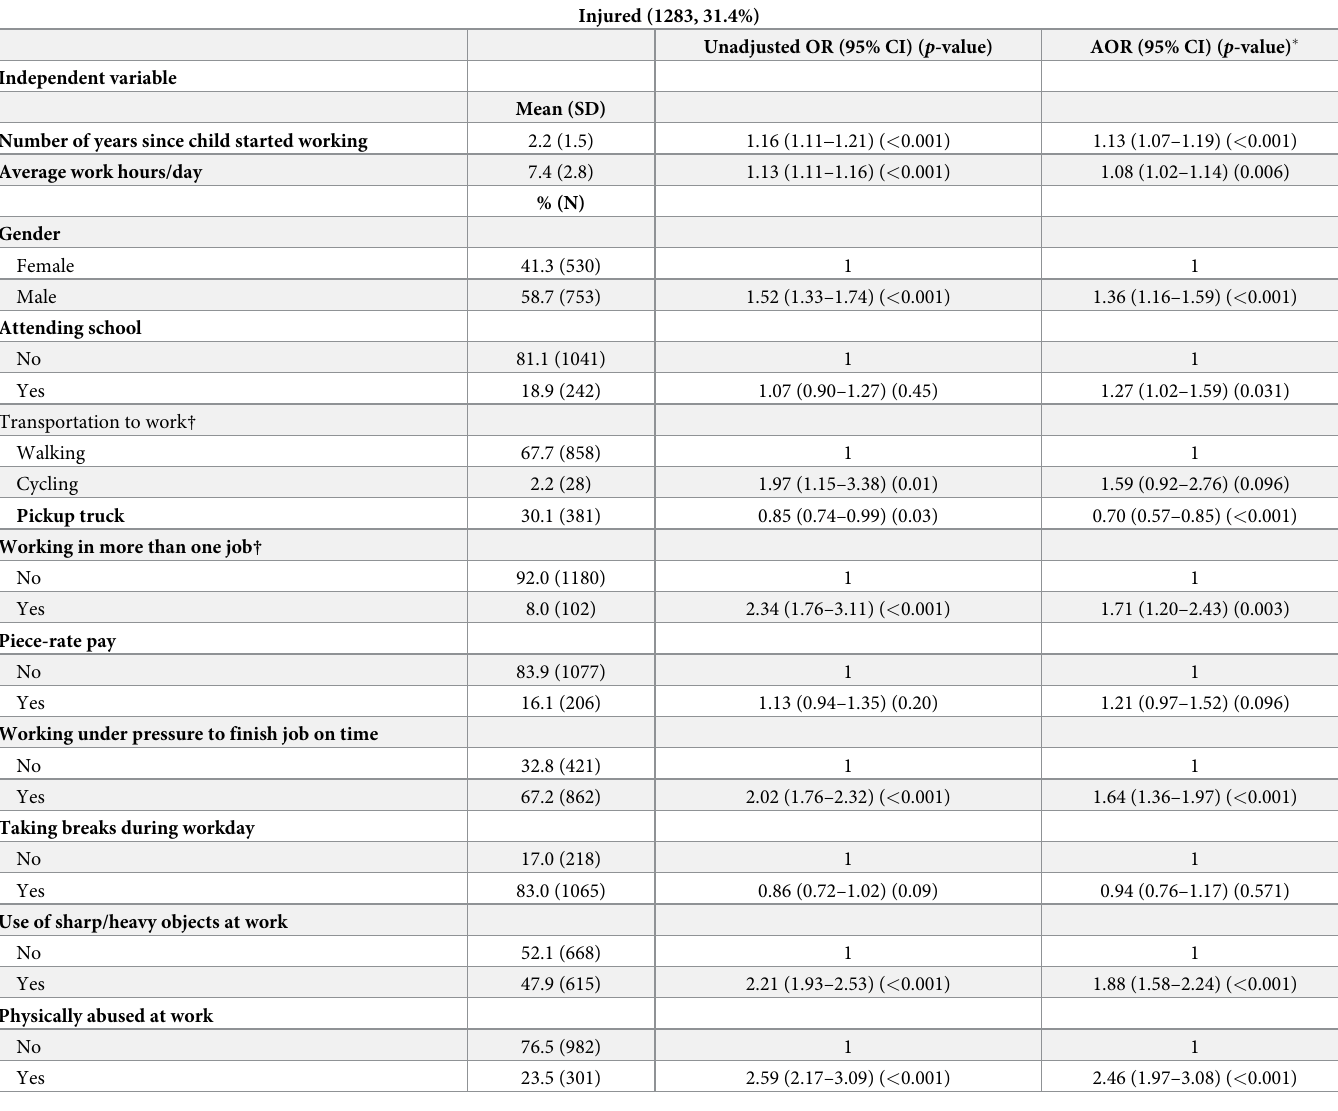
Table 6. Associations between sociodemographic, work characteristics and work-related injuries among Syrian refugee working children (8–18 years) in the Bekaa Valley, Lebanon, 2017 (N = 4090). Injured (1283,